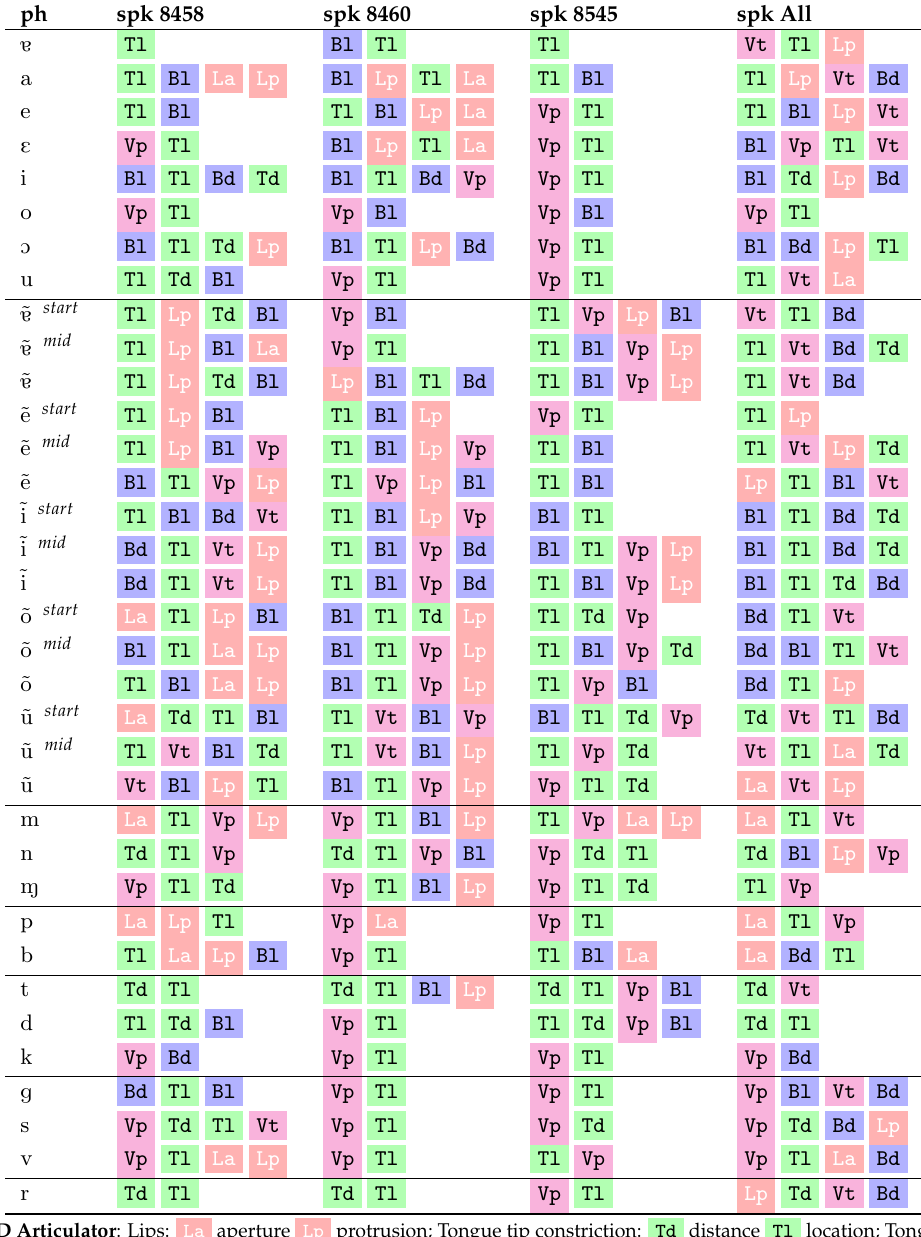
Table 4. Critical articulators for the different phones and speakers. Each component of the considered tract variables is considered an articulator (1D analysis). For the sake of brevity, for phones yielding a list of more than four critical articulators, only four articulators are presented. The order of the articulators reflects their determined importance. For the sake of space economy, in the tract variable listing the T and C were omitted, for example, TBCd became